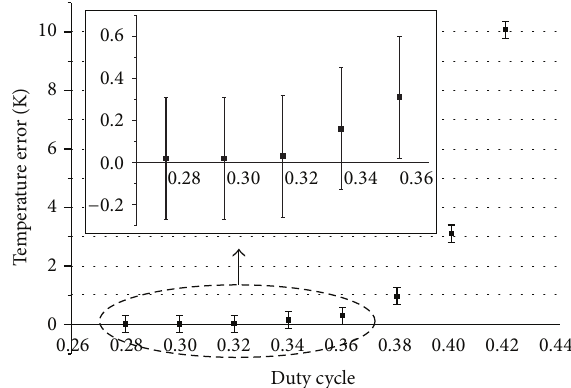
Figure 10: Plot of the temperature error with duty cycles ranging from 0.28 to 0.42 by a step of 0.02.